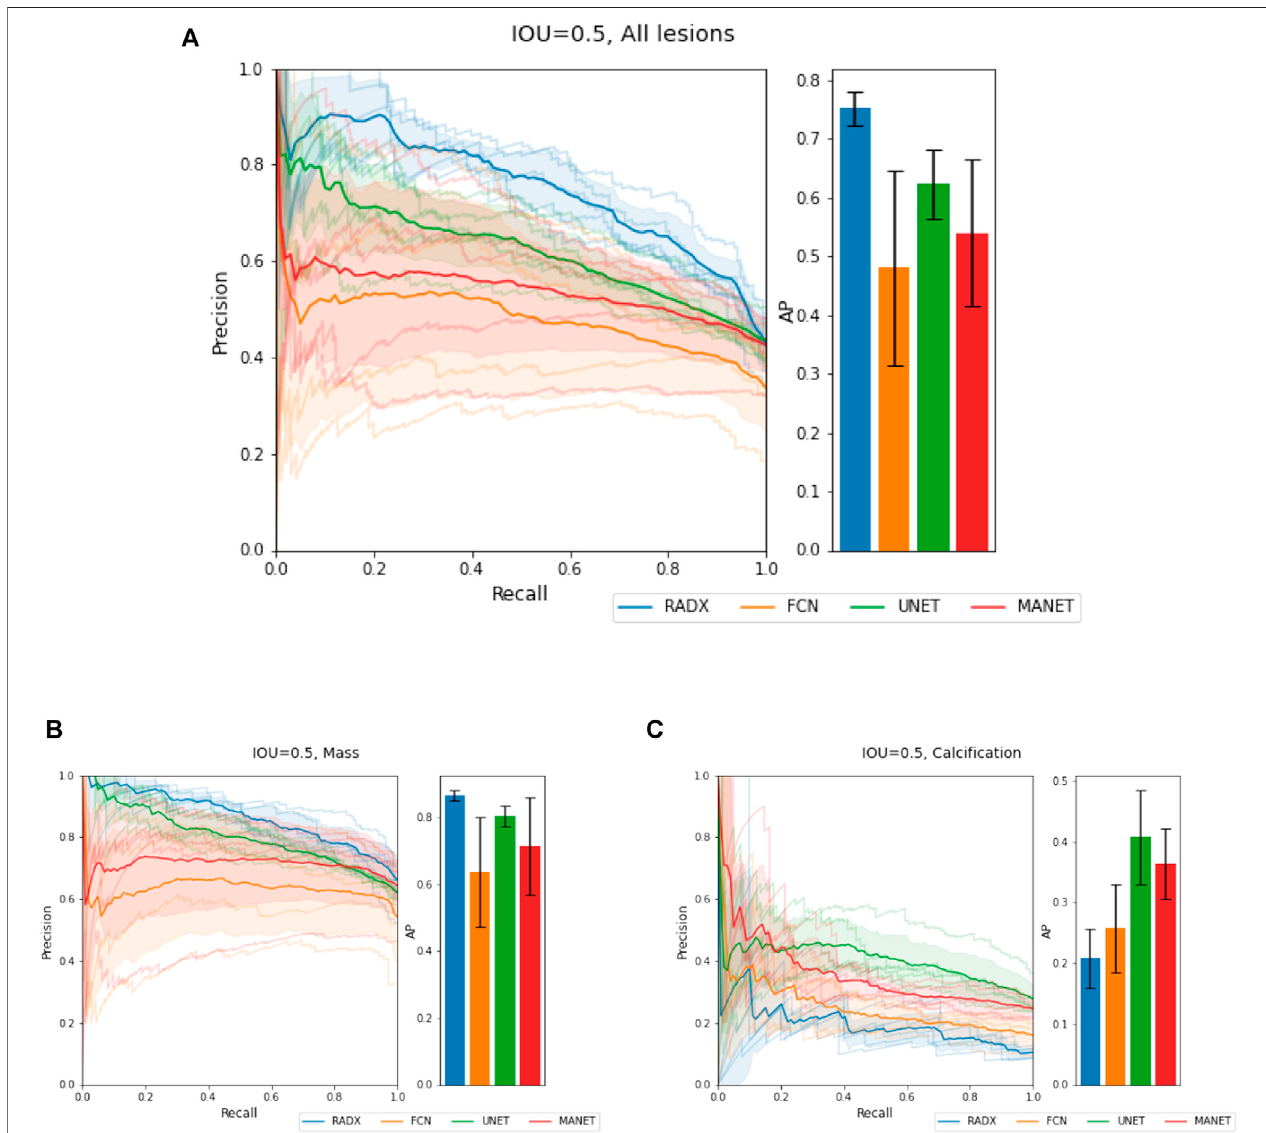
FIGURE 5 | Segmentation Characteristics. Segmentation performance of LatentCADx (LCX) was measured using Average Precision (AP) based on precision- recall, for fi xed Intersection Over Union (IOU) thresholds. (A) For IOU (cid:1) 0.5 on all types of lesions, LatentCADx obtained the highest AP, followed by comparable segmentation models U-Net and FCN. Further breakdown on performance is given by separating predictions for lesions by (B) Mass, where LatentCADx also obtained the highest AP and (C) Calci fi cations.